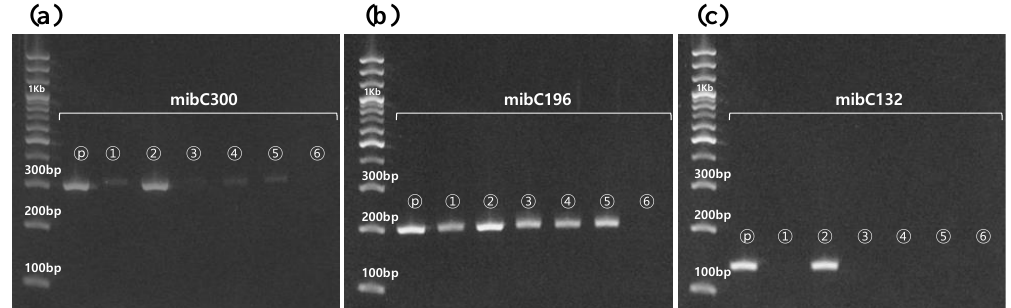
Figure 3. Amplification of the 2-MIB-synthesizing gene mibC by the primers mibC132, mibC196, and mibC300 using the genomic DNA of cyanobacteria strains isolated from the North Han River. The PCR product generated by each primer set was analyzed by agarose gel electrophoresis. The electrophoresis gel shows the amplicons produced by PCR with ( a ) mibC300 primer, ( b ) mibC196 primer, and ( c ) mibC132 primers. P. mucicola did not harbor mibC . Lane numbers in the figure represent Pseudanabaena galeata NIES-512 as a positive control (P), Phormidium ambiguum (1), Planktothricoides raciborskii (2), Lyngbya murrayi (3), Leptolyngbya boryana (4), Limnothrix redekei (5), and Pseudanabaena mucicola (6).